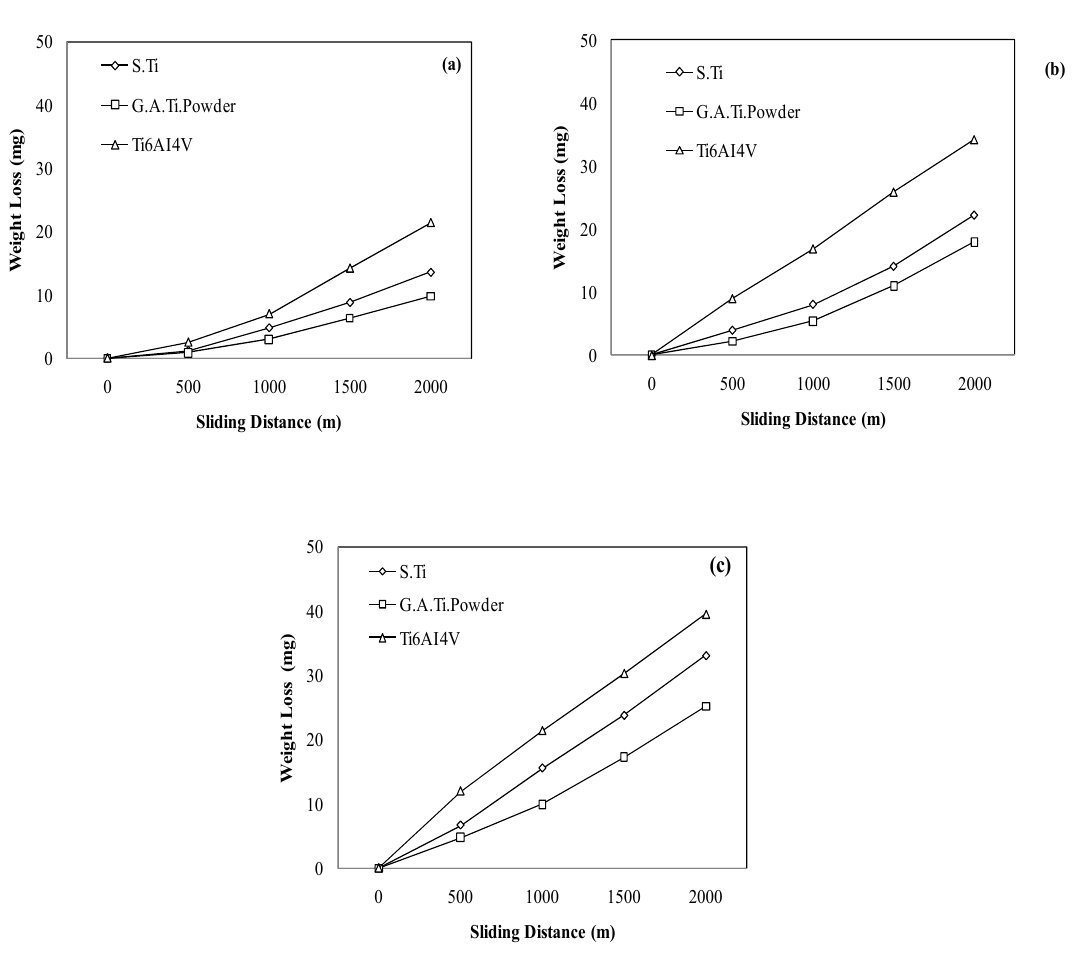
Figure 5. Wear losses of the sponge titanium, gas atomised titanium and Ti6Al4V alloy under the loads of a) 15 N, b) 30 N and c) 45 N.